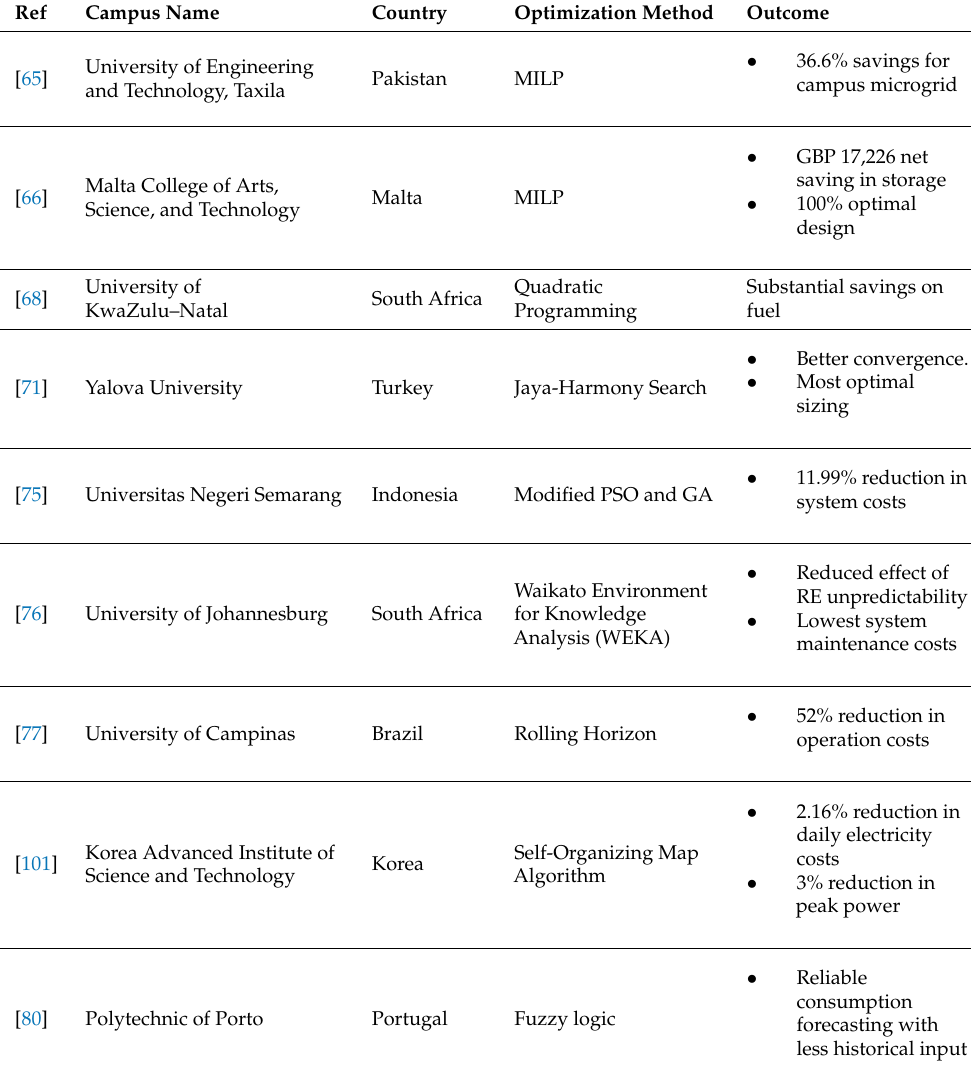
Table 2. Some optimization techniques from the latest campus microgrid